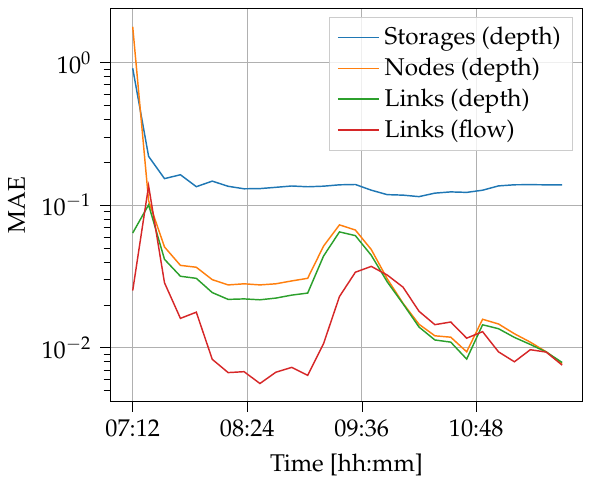
Figure 9. Category-wise mean absolute error (MAE) of the estimated